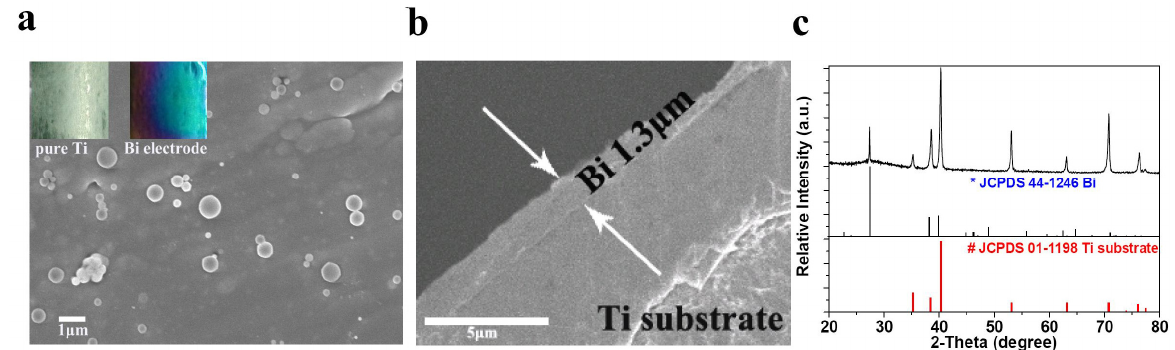
Figure 1. ( a ) Field emission scanning electron microscopy image of bismuth electrode. The insets are the optical pictures of bare substrate and bismuth electrode; ( b ) The cross-sectional scanning electron microscopy (SEM) image and ( c ) X-ray diffraction pattern of bismuth